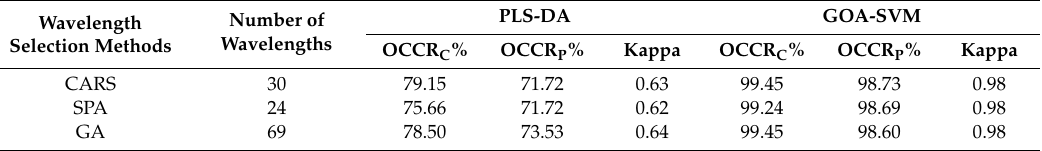
Table 3. Performance of PLS-DA and GOA-SVM simplified